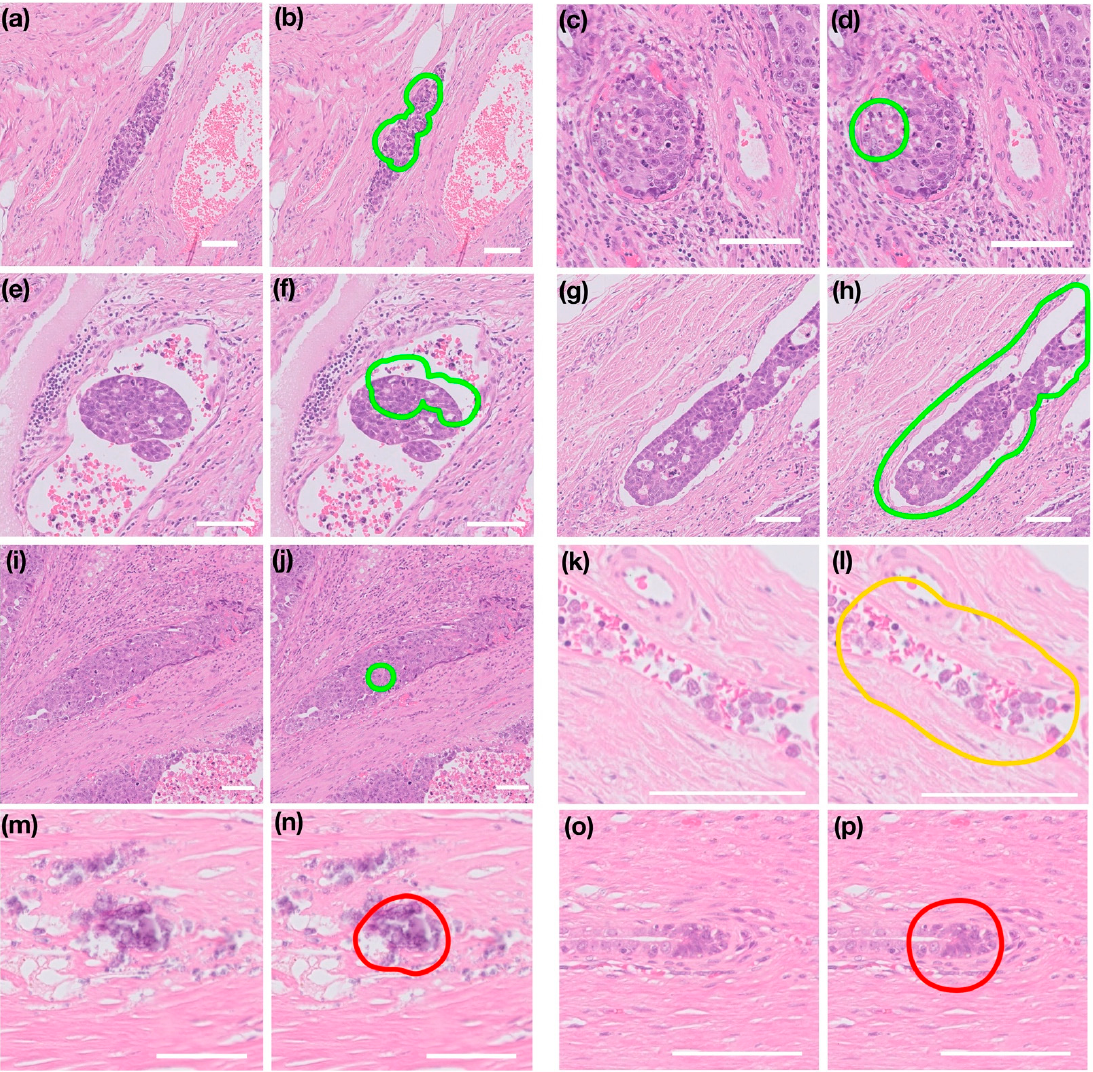
Figure 2. Examples of foci flagged by the deep-learning classifier model. Original images are shown in ( a , c , e , g , i , k , m , o ) and classifier output in ( b , d , f , h , j , l , n , p ). Images ( a – j ) show foci in which the presence of lymphovascular invasion (LVI) was agreed by consensus. Images ( k , l ) show a misclassified focus which was considered appropriate to highlight but negative for LVI (i.e., ‘equivocal’). Images ( m – p ) show examples of misclassified foci, ( m , n ) are embryonal carcinoma in tunica albuginea, and ( o , p ) are rete epithelium. Images are shown at varying magnification (scale bar is 100 µm in each).